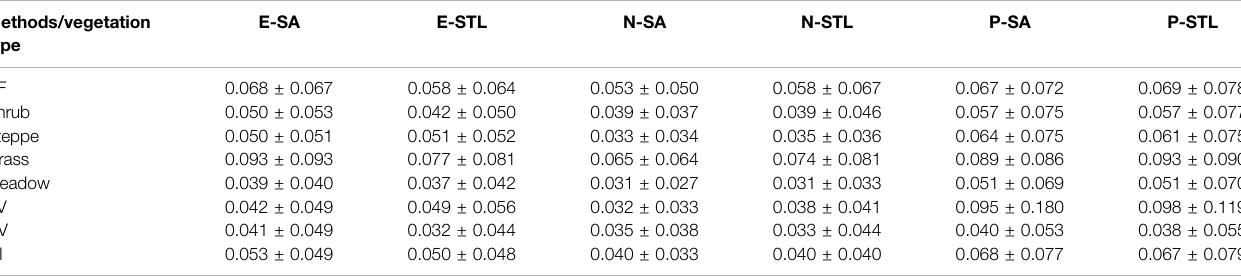
TABLE 4 | The means and standard deviations of SOS spatial CV for different vegetation types. Methods/vegetation type